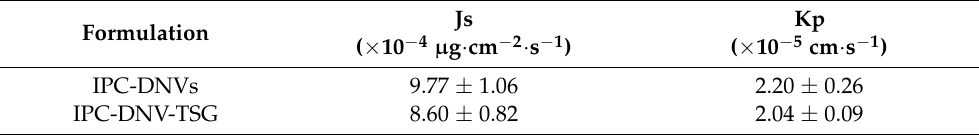
Figure 8. In vitro permeability profiles of IPC-DNVs and IPC-DNV-TSG across TR146 multilayered cells. Table 3. Penetration and transport of formulations ( n = 3).